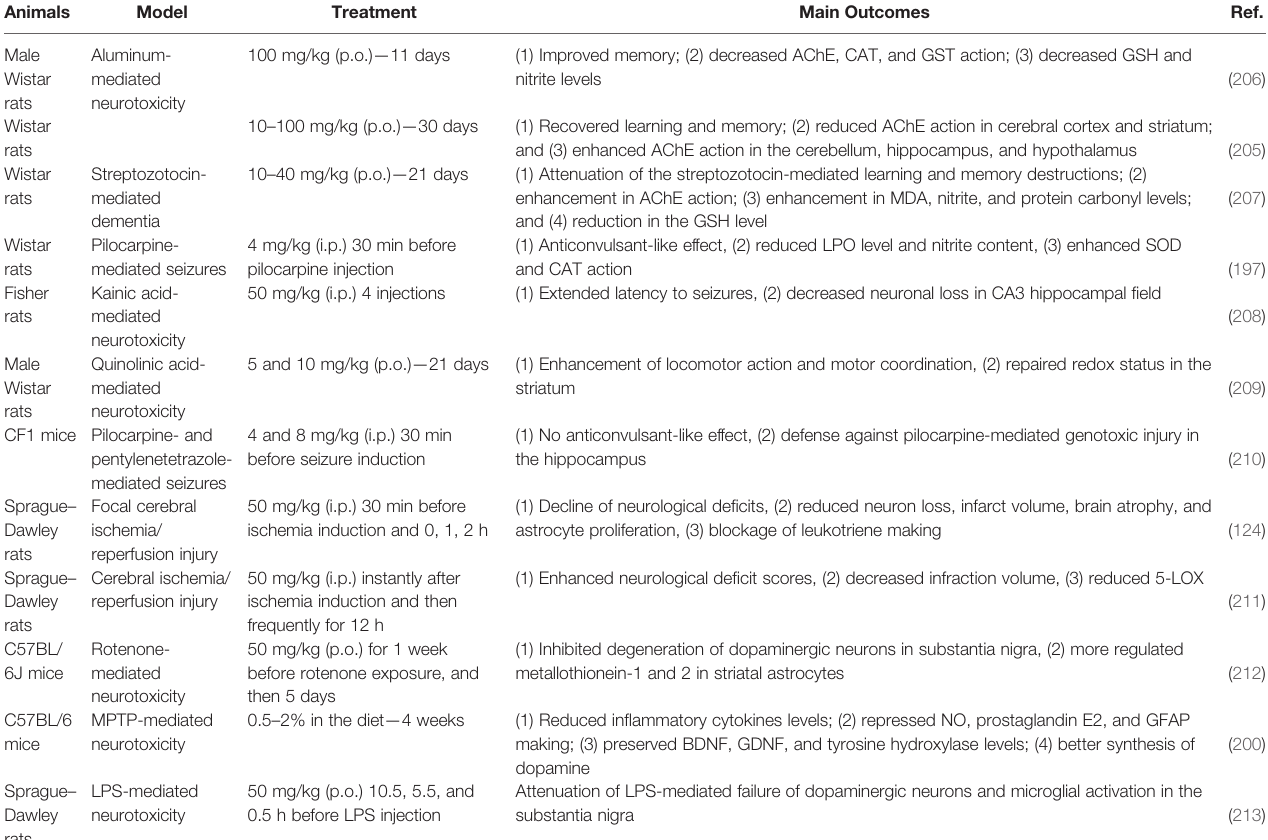
TABLE 1 | Summary of in vivo studies on the neuroprotective effects of caffeic acid. Animals Model Treatment Main Outcomes Ref.